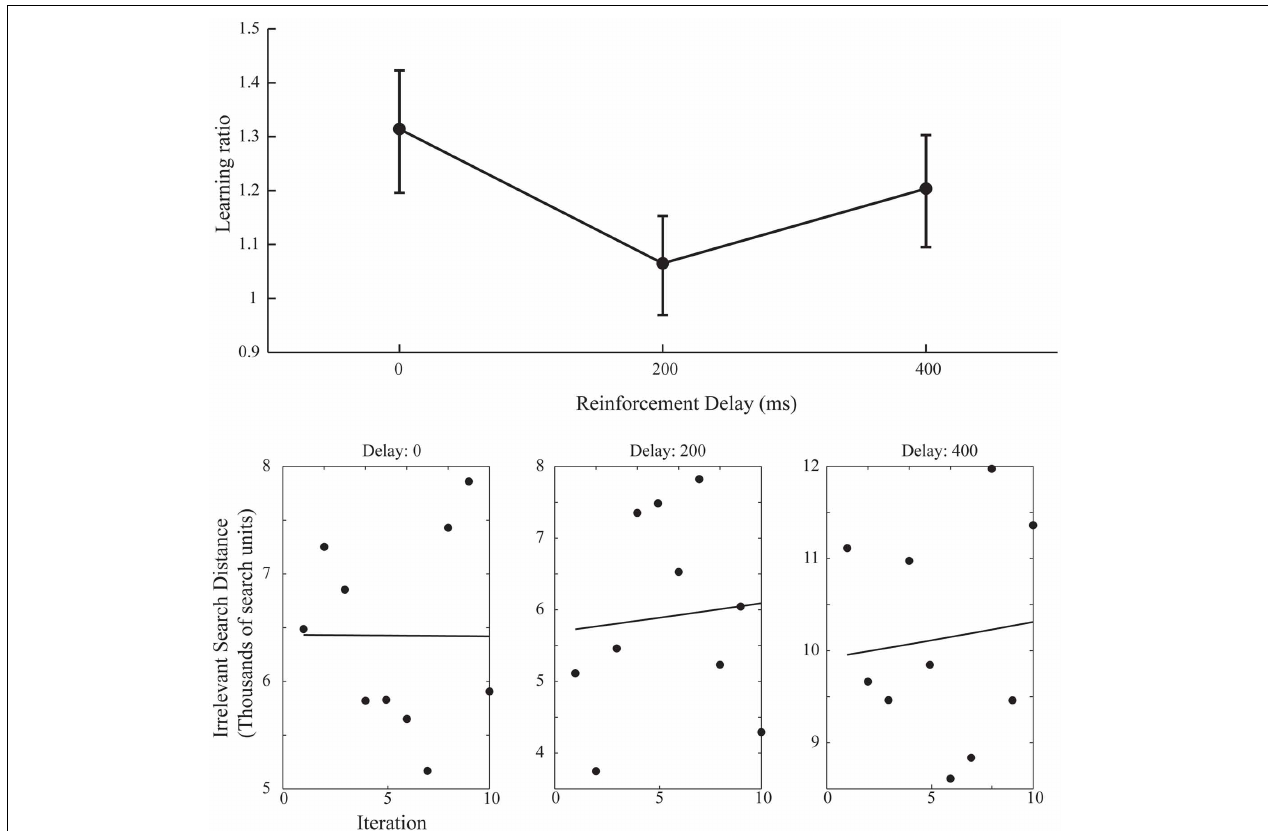
FIGURE 6 | Learning ratios and fitted performance data for experiment 2. Compared to the learning ratios of experiment 1 ( Figure 3 ) we again see no effect of delay on learning ratio but dramatically reduced values for said ratios (upper axis). Unlike in experiment 1 ( Figure 4 ) the power law curve shown on the lower